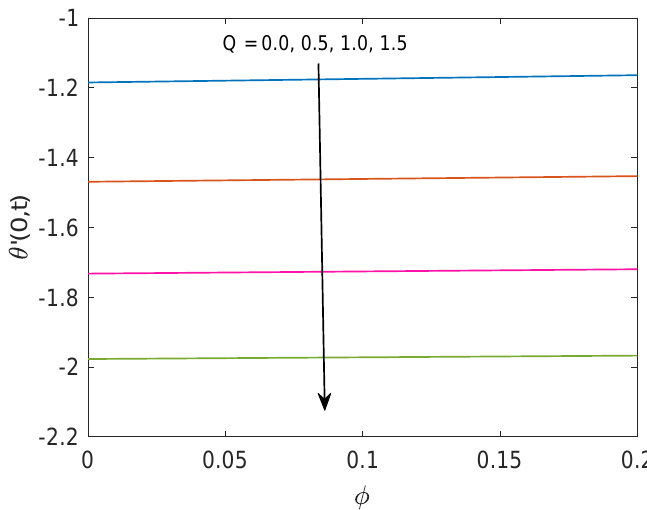
Figure 19. Profile of heat transfer rate for different Q when Nr = 1.5, Pr = 6.2 and t = 0.5.